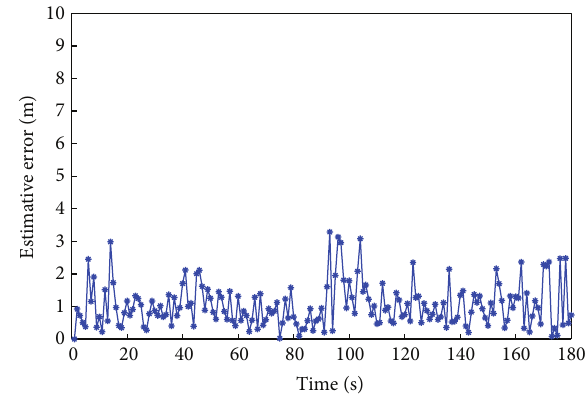
Figure 9: The estimation error result with optimal sensing radius for path 2 movement.